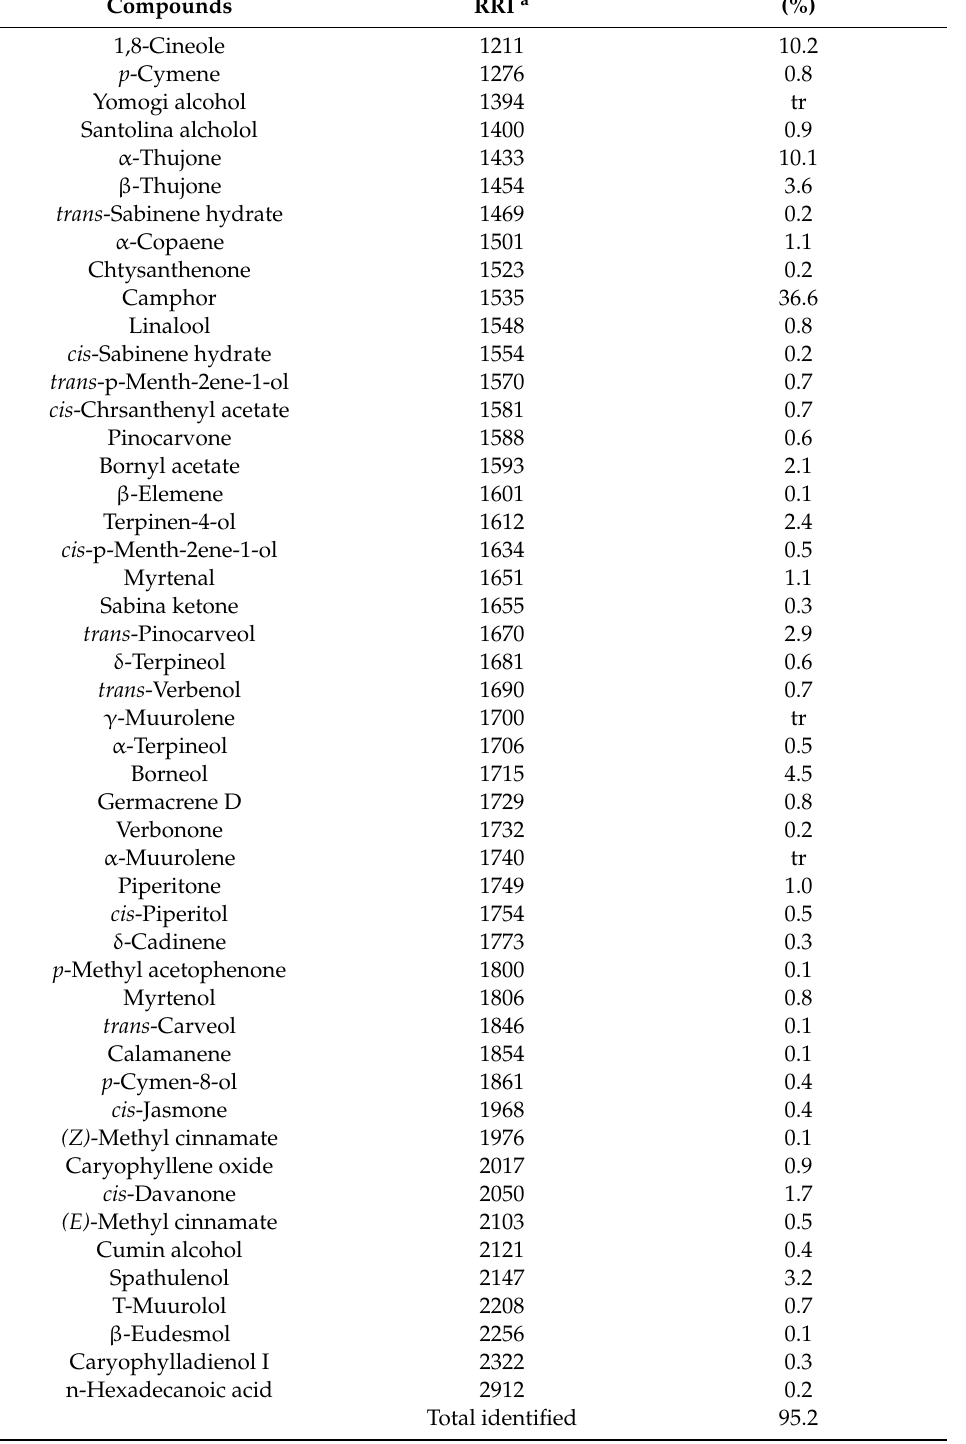
Table 1. Chemical composition of Artemisia santonicum essential